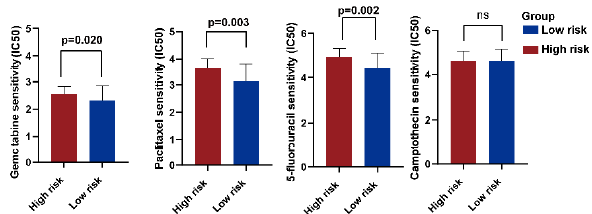
Figure 8. The predictive evaluation of treatment responses for several common chemotherapeutic drugs in PC by the novel prognosis score based on the NMG signature. “ns” stands for no significant difference between the values from the two groups.